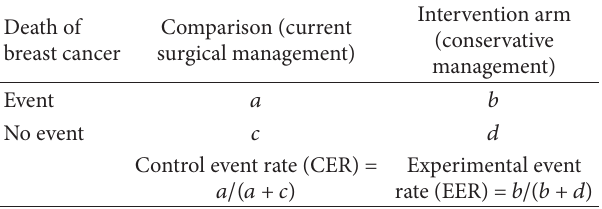
Table 1: Primary outcome, breast cancer specific mortality.